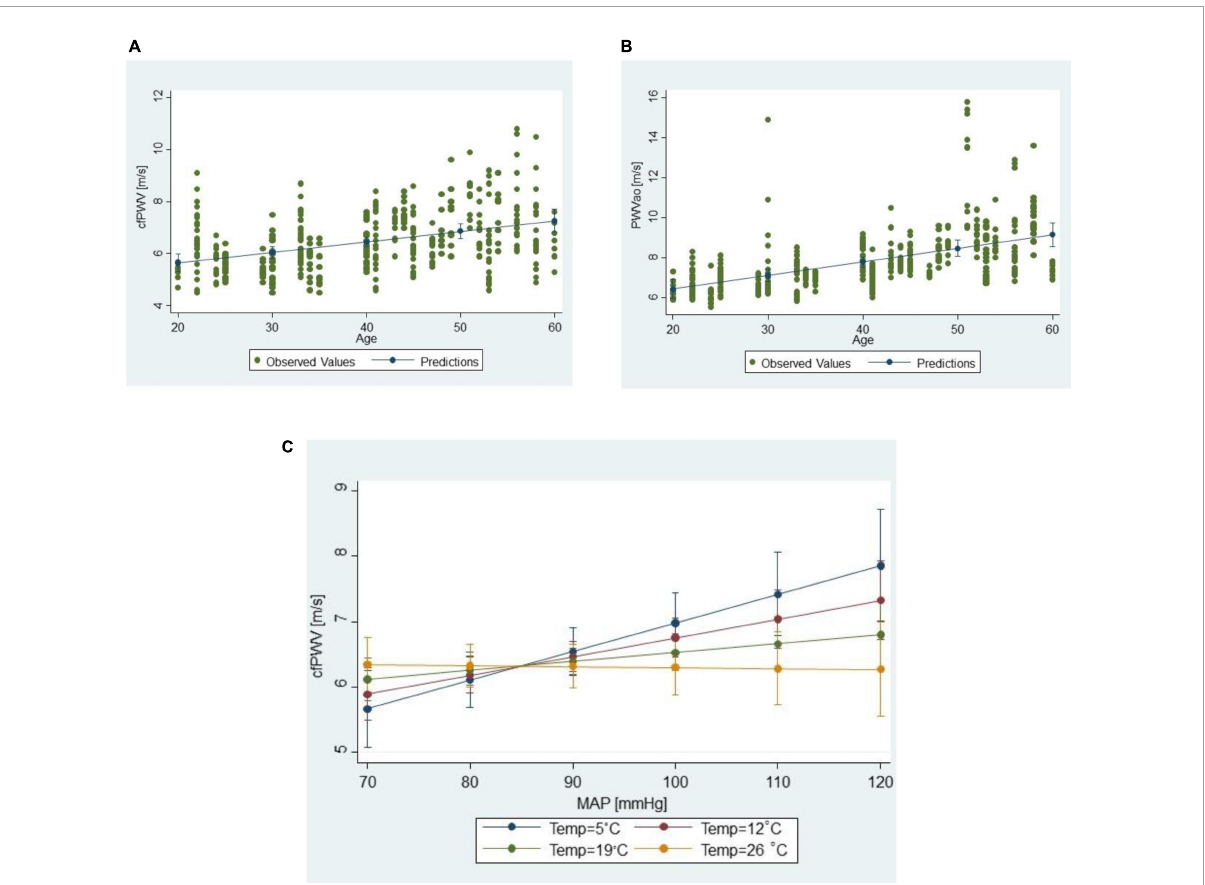
FIGURE4 Scatter plots of (A) cfPWV measurements vs. age, and (B) PWVao measurements vs. age; (C) moderation interaction of the outdoor temperature on the relationship between cfPWV values and MAP; lines connect predictive margins of the multilevel regression model with 95%